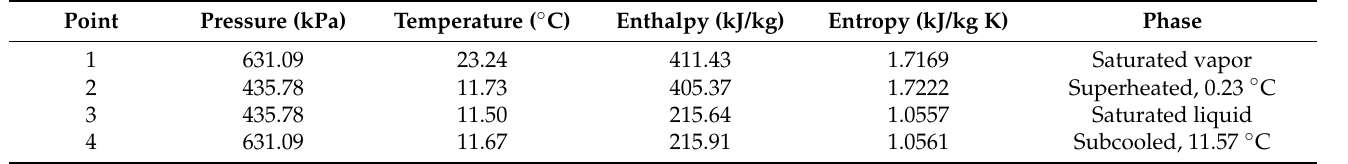
Table 2. The optimal state parameters of the ORC under the solution of Point